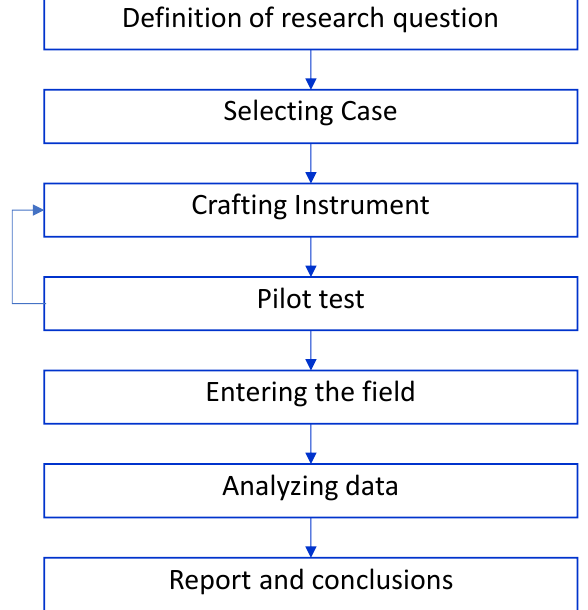
Figure 1. Case study methodology . Source: Adapted from [17,18].